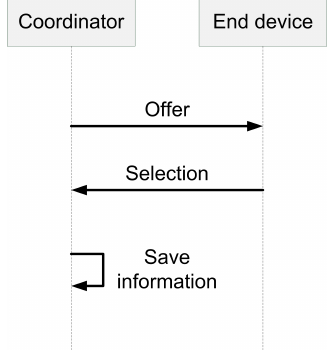
Figure 3. Exchange of control